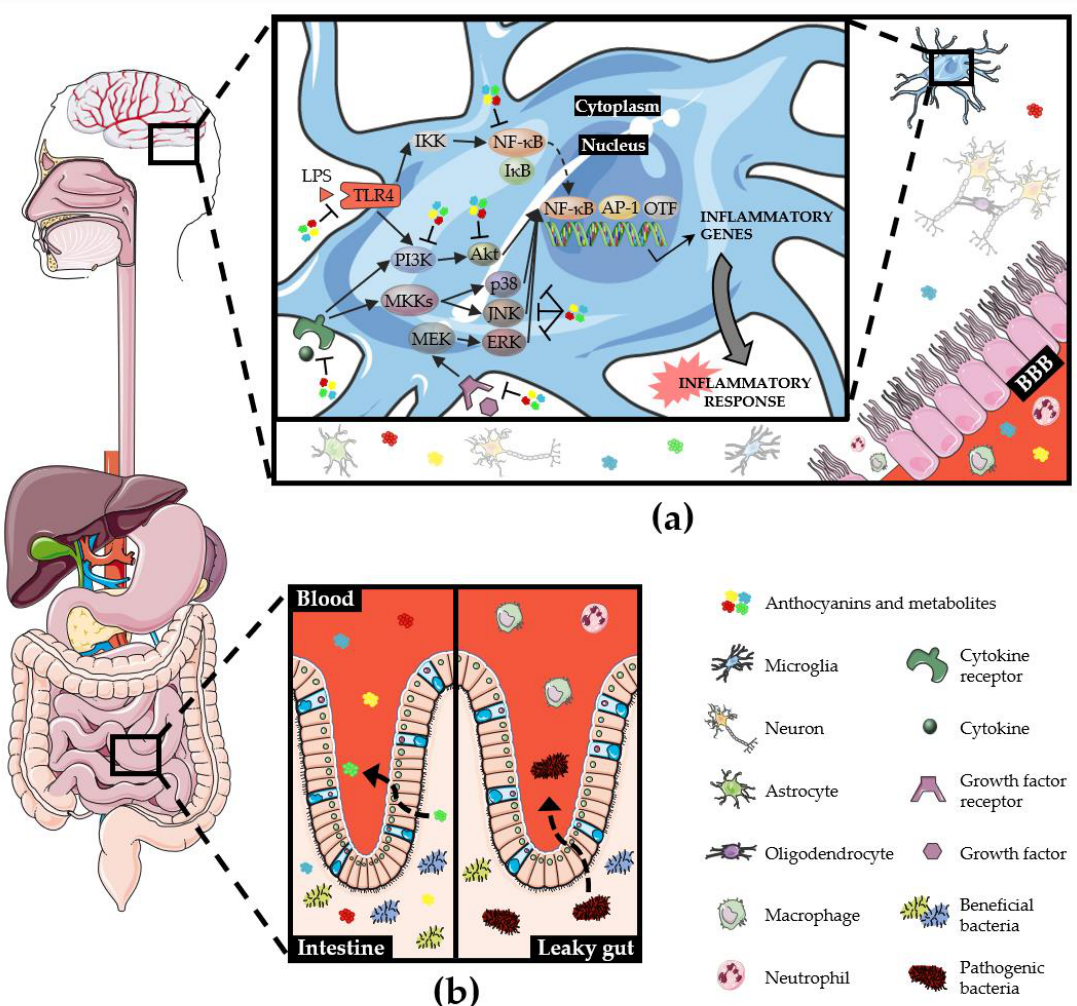
Figure 3. Schematic overview of regulation of microbiota–gut–brain axis by anthocyanins and their metabolites. ( a ) Peripheral inflammatory cells infiltrate into the brain, eliciting microglia activation which involves several inflammatory signaling pathways that can be modulated by anthocyanins and their metabolites; ( b ) Anthocyanins can be absorbed in the intestine, where they firstly promote the proliferation of beneficial bacteria and contribute to the elimination of pathogenic bacteria. The dysregulation of gut microbiota (dysbiosis) or the increase in the intestinal pathogenic community can lead to the disruption of gut wall mucosa (leaky gut), inciting a systemic inflammation and intensifying the neuroinflammatory response. Akt: Protein kinase B; AP-1: Activator protein 1; BBB: Blood–brain barrier; ERK: Extracellular signal-regulated kinase; IĸB: NF-ĸB inhibitor; IKK: IĸB kinase; JNK: c-Jun N-terminal kinase; LPS: Lipopolysaccharide; MEK: Ras/Raf/mitogen-activated protein